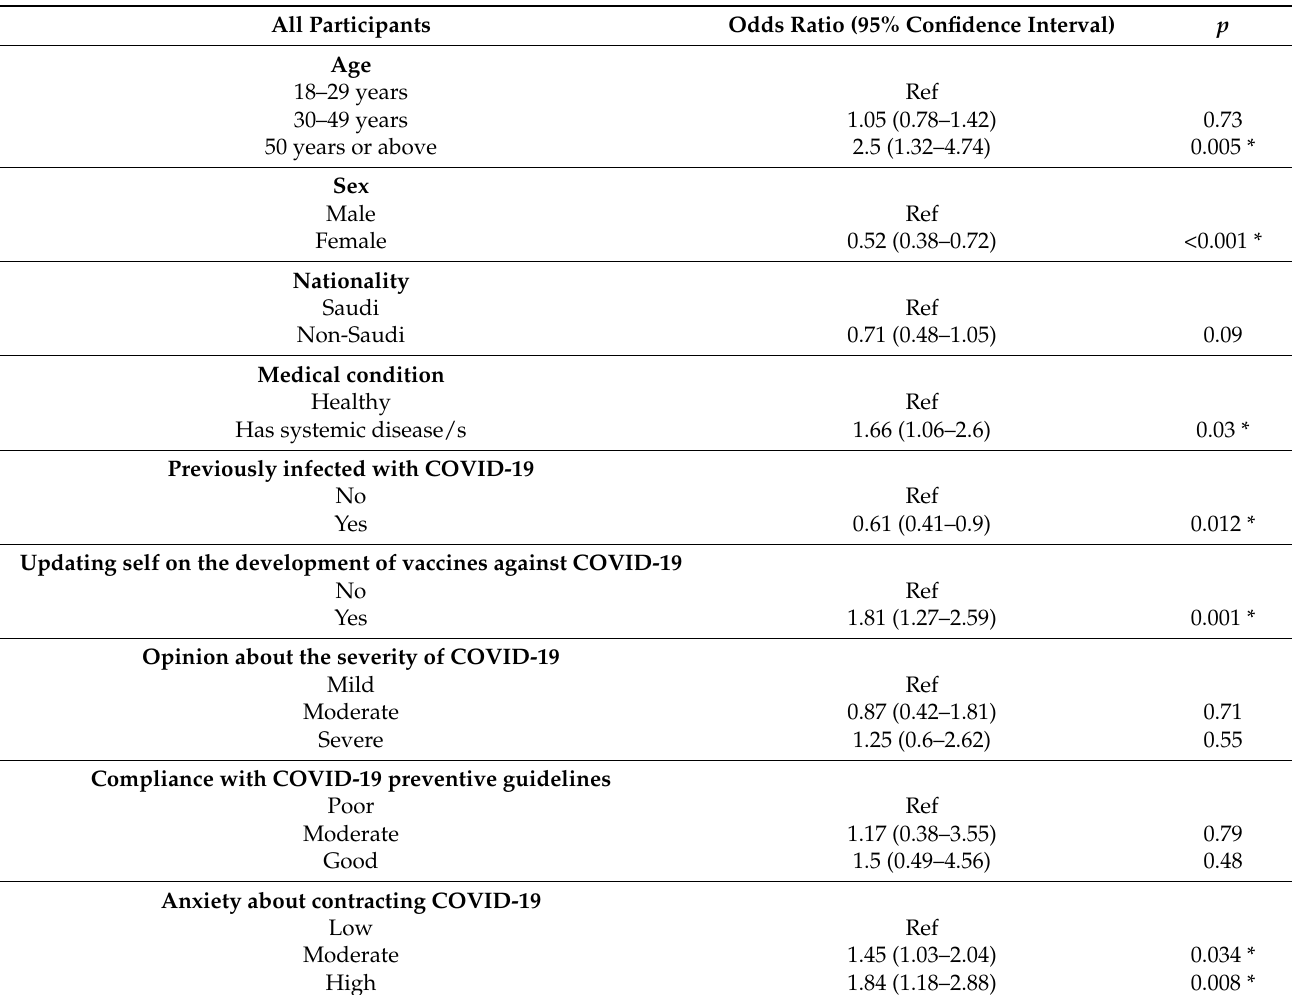
Table 6. Predictors of intention to